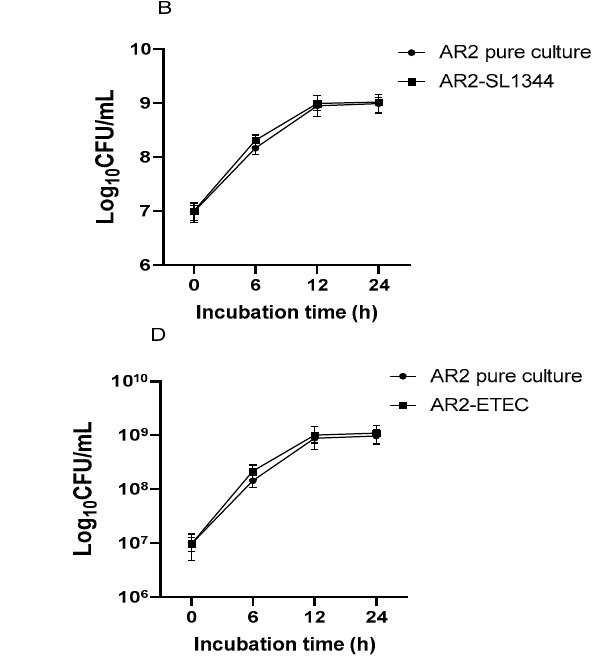
Figure 5. Growth pattern of L. acidophilus AR2 in pure culture and co-culture with S. Typhimurium ATCC14028 ( A ), S. Typhimurium SL1344 ( B ), S. aureus ( C ), and ETEC ( D ).